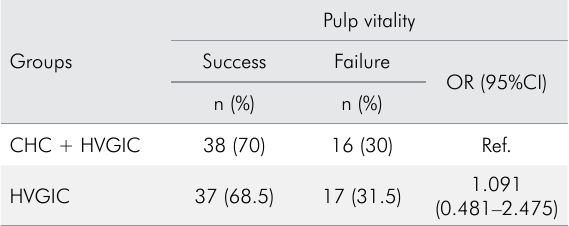
Table 2. Logistic regression analysis comparing pulp vitality between the groups.